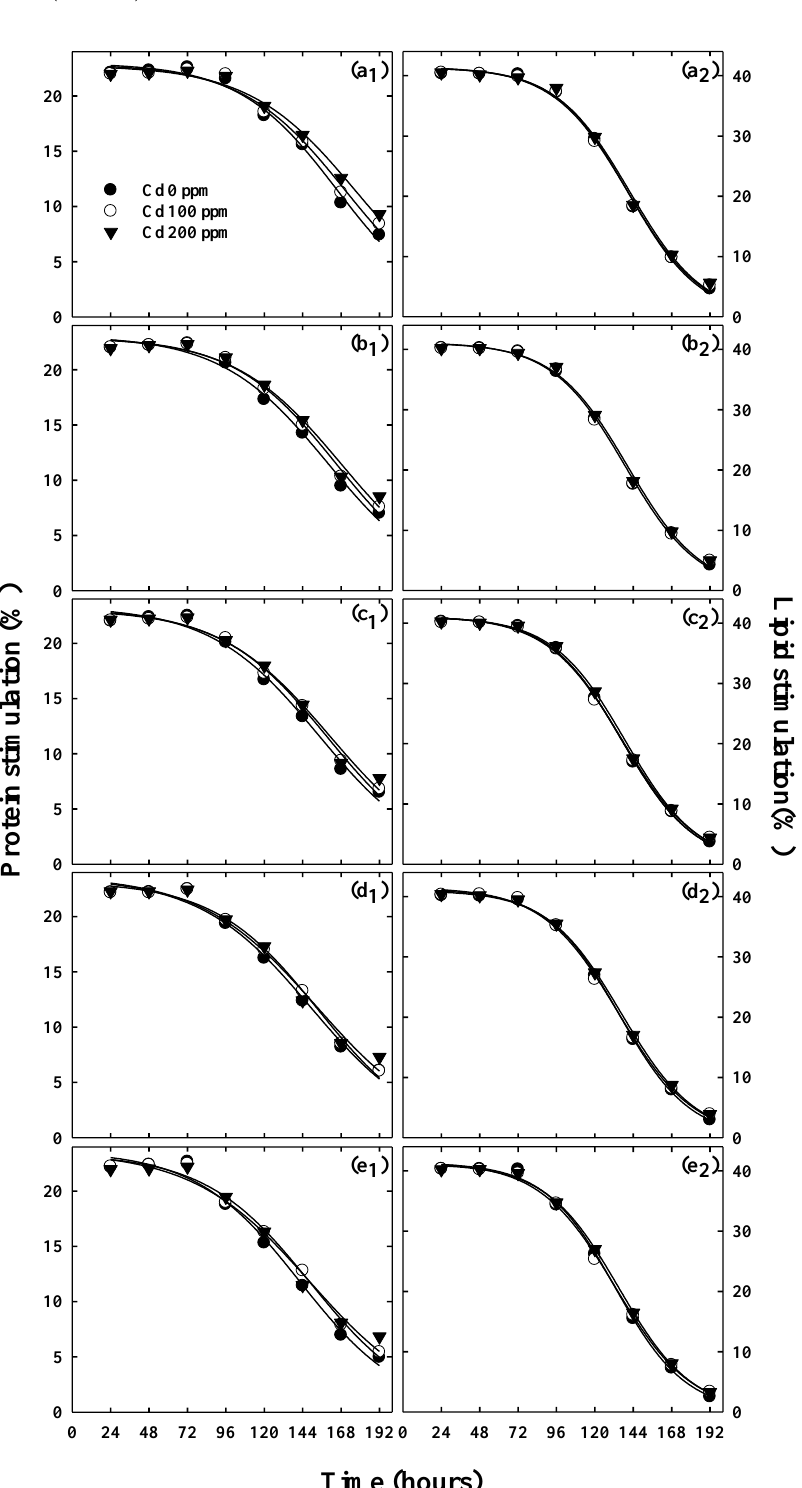
Figure 2. The effect of humic acid on protein stimulation (right plots) and lipid stimulation (left plots) at different times after imbibition under Cd stress. ( a 1 ) and ( a 2 ), 0 mg.L −1 ; ( b 1 ) and ( b 2 ), 100 mg.L −1 ; ( c 1 ) and ( c 2 ), 200 mg.L −1 ; ( d 1 ) and ( d 2 ), 300 mg.L −1 ; and ( e 1 ) and ( e 2 ), 400 mg.L −1 .